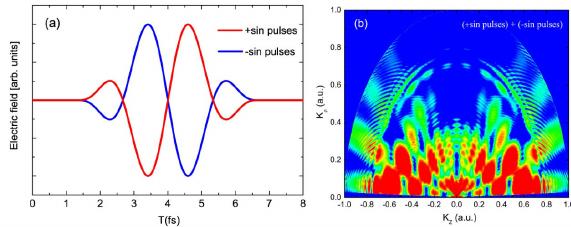
Figure 8. (Color online) ( a ) Temporal variation of the electric field of few-cycle pulsed laser with phase ϕ = π /2 (“-sinelike”, blue line) and ϕ = 3 π /2 (“+sinelike”, red line). ( b ) The photoelectron momentum spectrum of H(1 s ) state ionized by an alternate field with the same laser parameters but with carrier phase π /2 and 3 π